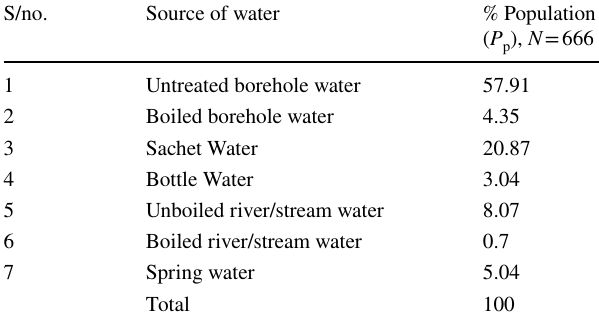
Table 4 Sources of drinking water S/no.